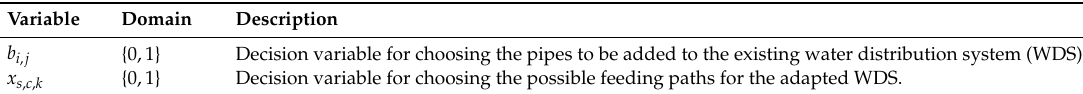
Table 1. Decision variables of the optimization program.